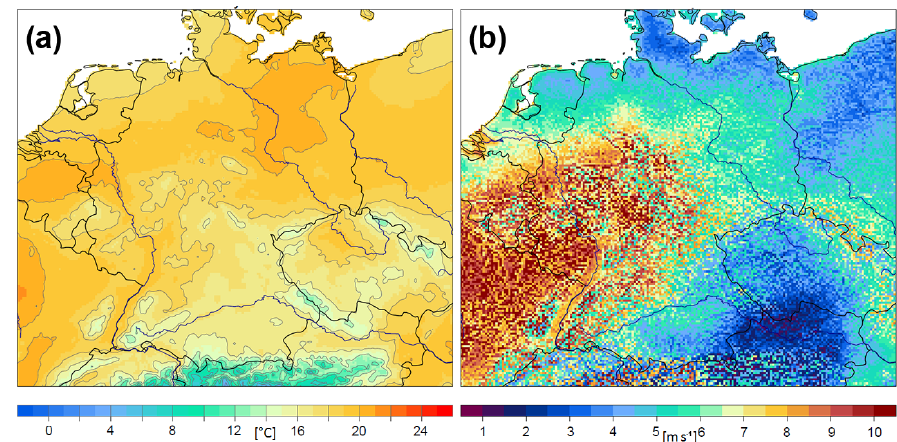
Figure 13. Detailed image of central Europe for (a) daily mean temperature (31 July 2010) and (b) daily mean wind speed (28 February 2010).